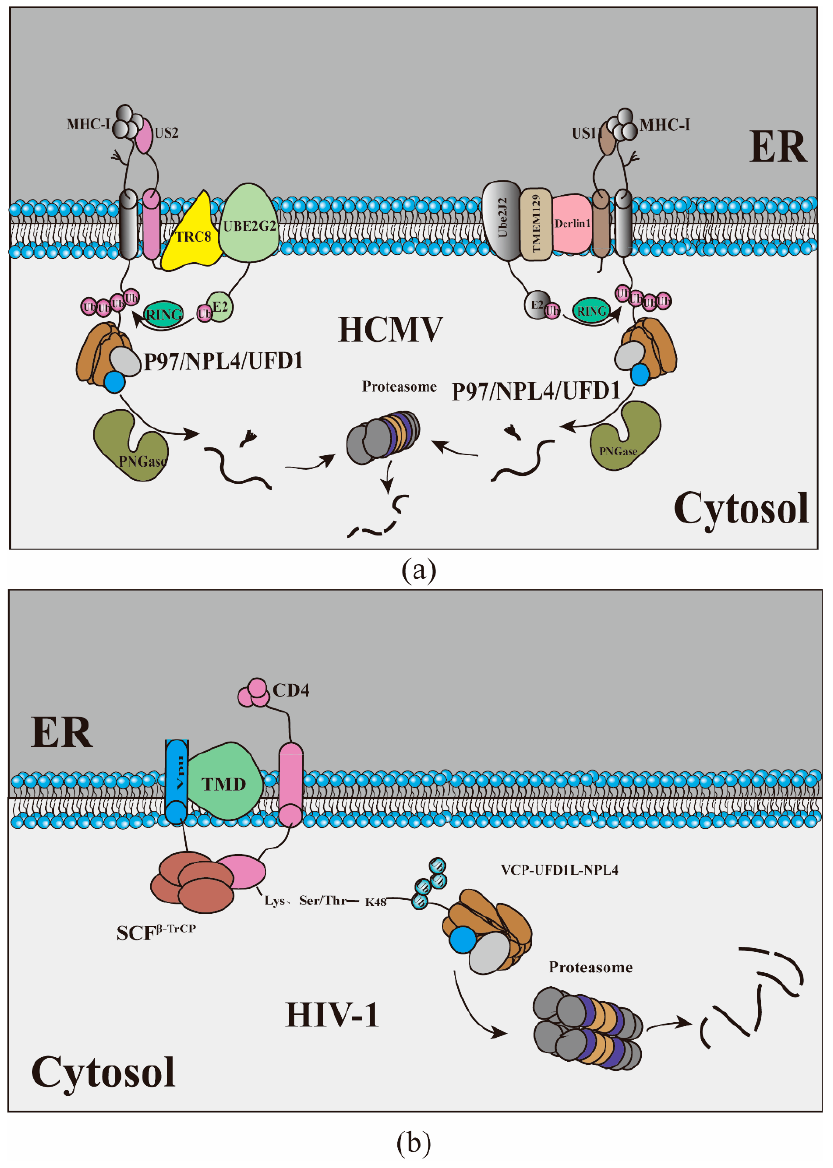
Figure 3. How viruses interfere with the immune system. ( a ) US11 recruits TMEM129, and TMEM129 recruits Ube2J2 for US11-induced MHC-I ubiquitin through Derlin1. US2 recruits TRC8 for US2-induced MHC-I ubiquitin. ( b ) HIV-I targets newly synthesized CD4 receptors and rapidly degrades CD4 through ERAD.